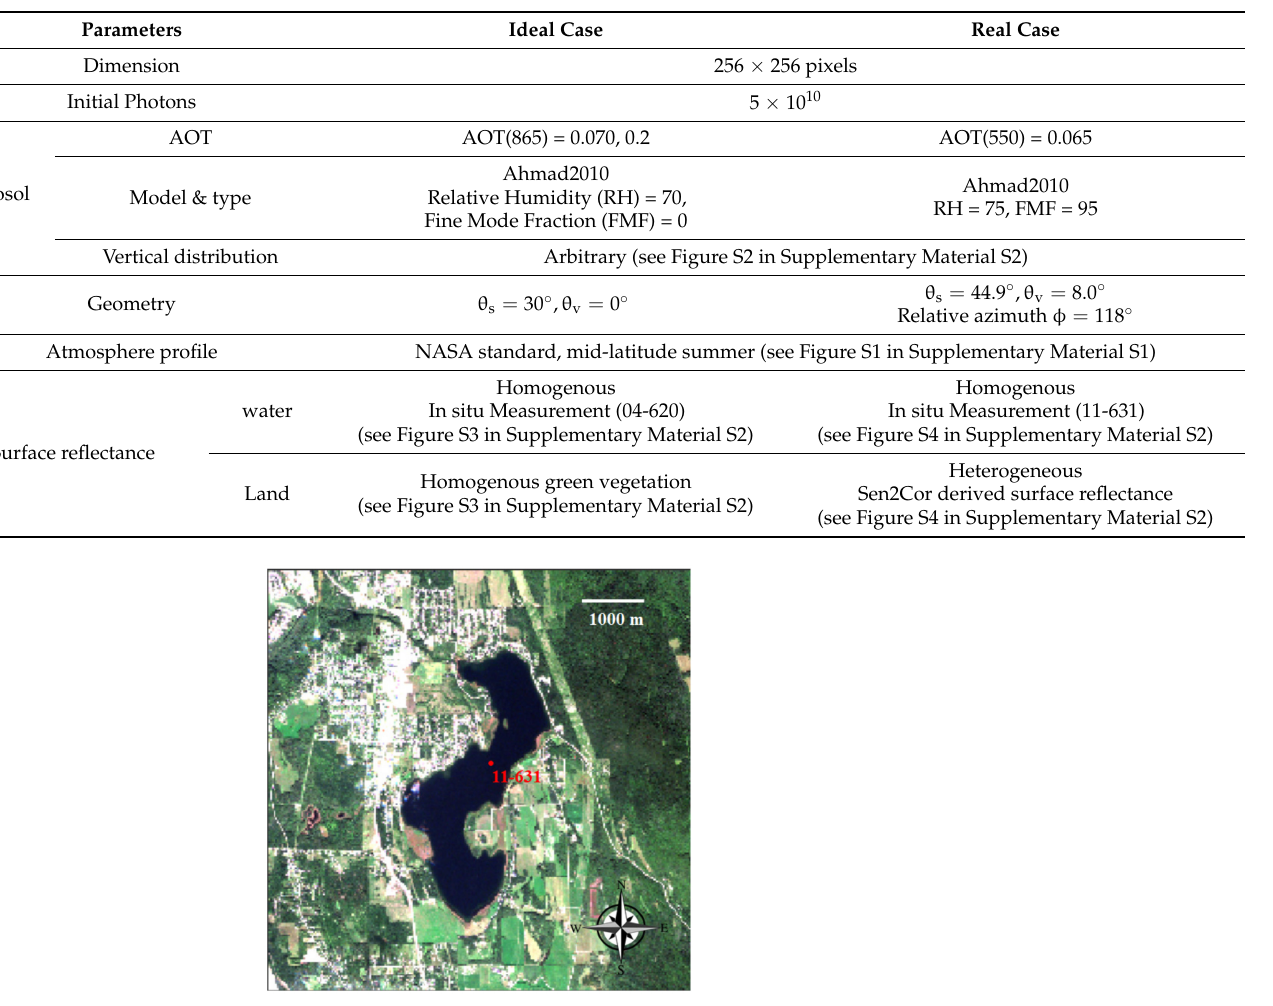
Figure 5. Natural color image of Dragon Lake from S2B/MSI (S2B_MSIL1C_20190829 T190919_N0208_R056_T10UED_20190829T21). The location of the sampling station 11-631 is also